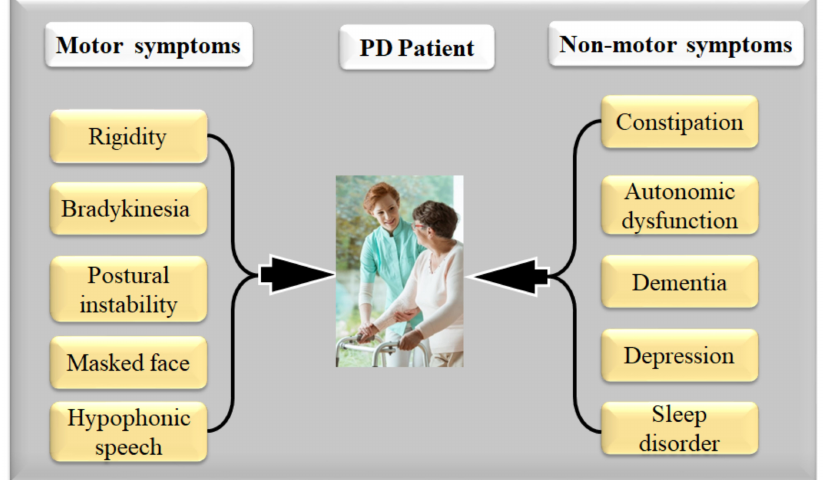
Figure 7. Motor and non-motor symptoms in PD patients with or without COVID-19 (Courtesy of AtheroPoint™, Roseville, CA, USA permission granted).